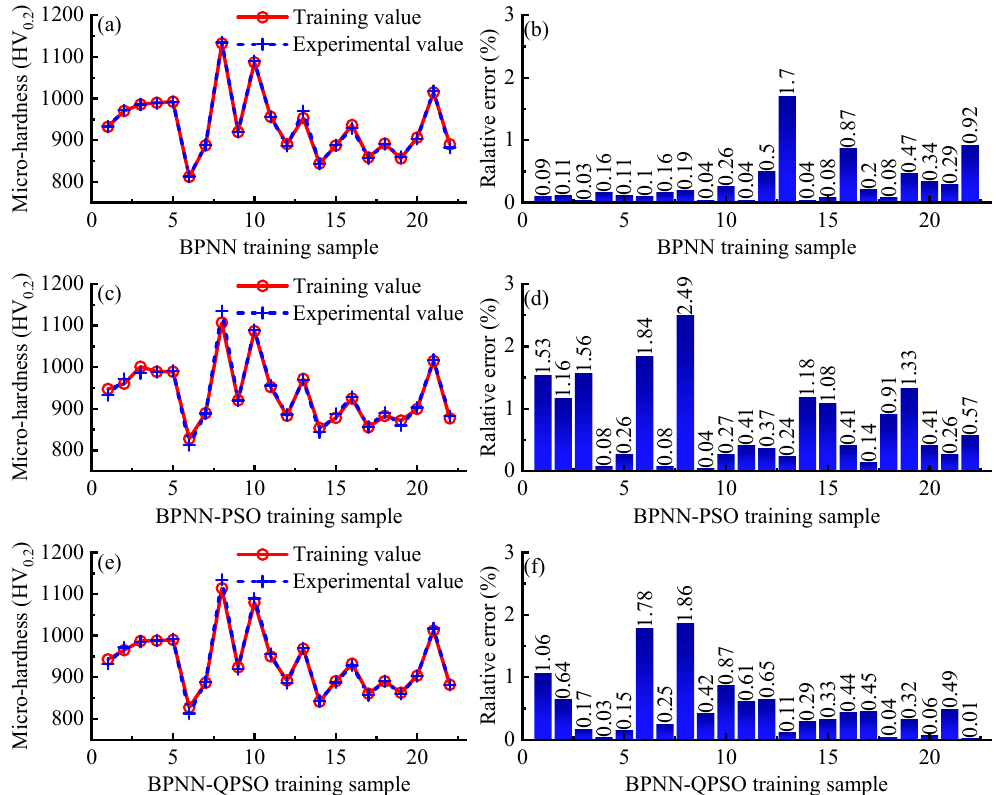
Figure 9. Comparison diagram of training values and experimental values of micro-hardness: ( a , b ) BPNN; ( c , d ) BPNN-PSO; ( e , f )